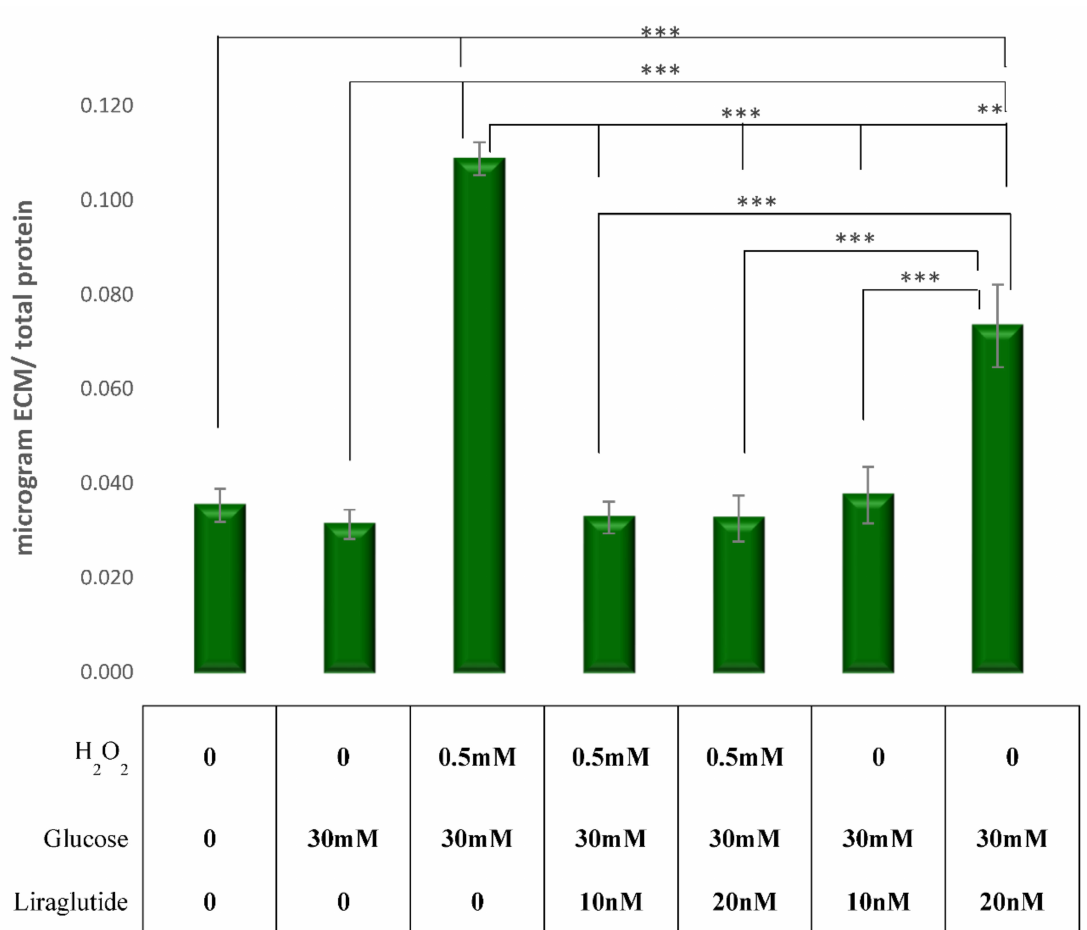
Figure 4. Levels of collagen synthesis in the experimental LLC-PK1-treated cell lines (control vs. HG30 and HG30/H 2 O 2 ; HG30 vs. HG30/Lira10 and HG30/Lira20; HG30/H 2 O 2 vs. HG30/H 2 O 2 /Lira10 and HG30/H 2 O 2 /Lira20). ECM measurements were done by spectrophotometry at 595 nm. One- way ANOVA F(9,26) = 49.73, p = 1.6 × 10 − 6 with Tukey HSD post hoc test; ** p < 0.01, *** p < 0.001. The values are represented in microgram ECM per total protein as average. Values underneath the x axis represent the amount of compound added in the experiment, and 0 represents that the compound was not added. The data are shown as the means ± SD (standard deviation) from three independent biological replicates. ECM measurement, pig proximal tubule cell line (LLC-PK1), HG (1.5 mM, 30 mM), H 2 O 2 (0.5 mM), Liraglutide (10 nM, 20